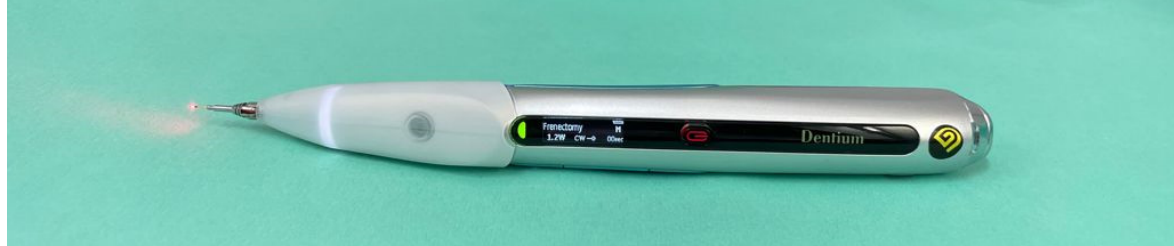
Figure 6. Positioning of the tongue and design of the incision line.